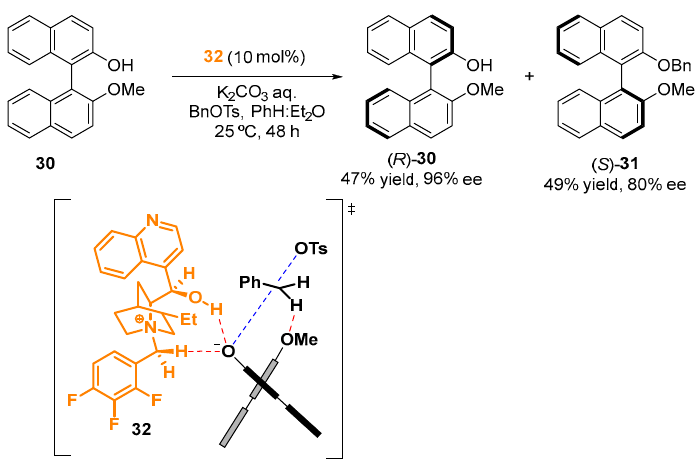
Scheme 21. Kinetic resolution of BINOL mediated by catalyst 32